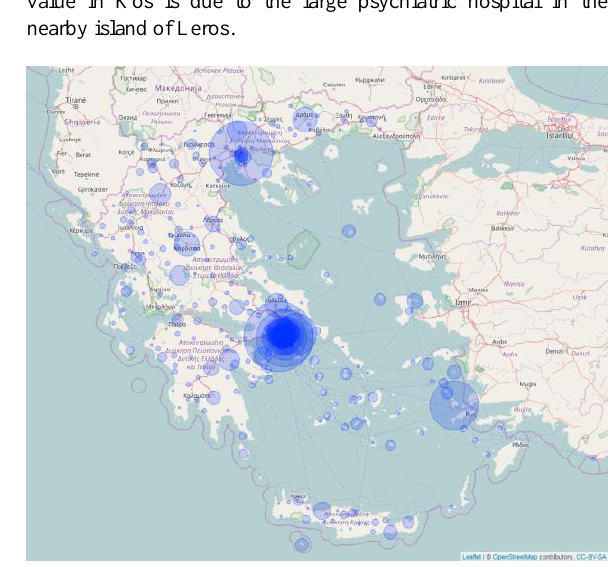
Figure 1. Spatial Accessibility to public